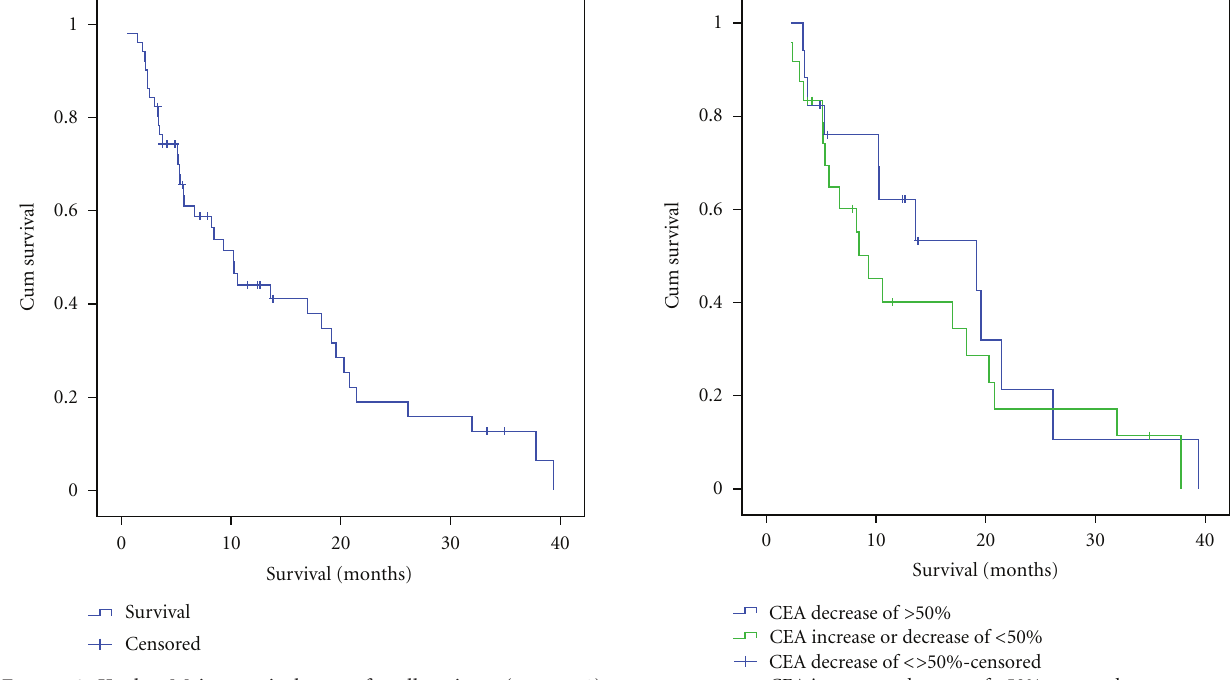
Figure 2: Kaplan-Meier survival curve for all patients ( n = 51) treated with 90 Y radioembolization. Survival was calculated from time of the first treatment with 90 Y. Median survival was estimated to be 10.2 months. The 95% confidence-interval is 7.5–13.0 months.